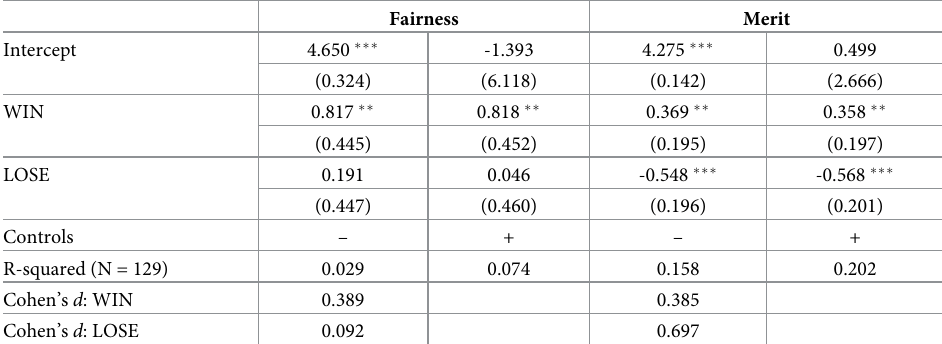
Table 2. Regression results (s.e. in